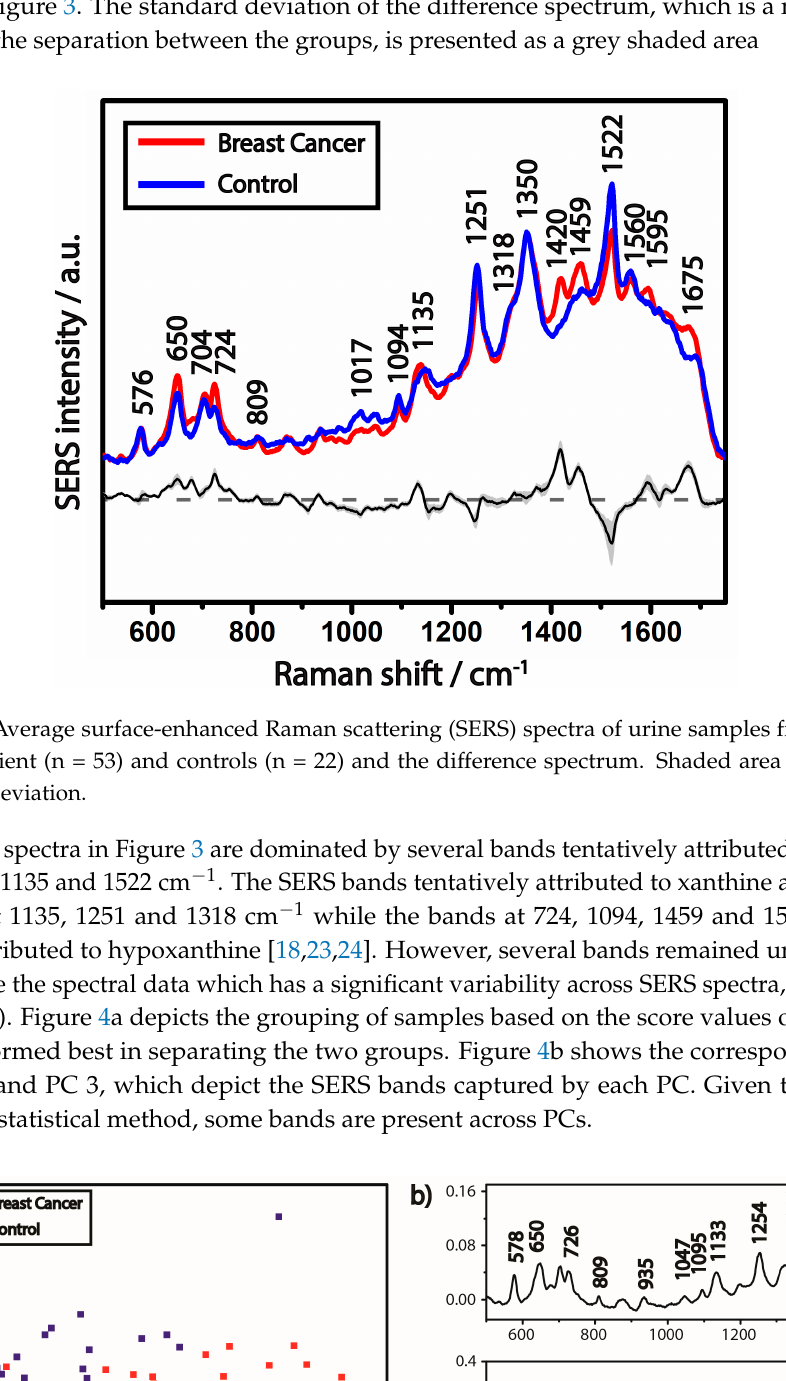
Figure 4. Principal component analysis of SERS acquired from patients with breast cancer (n = 53) and controls (n = 22). Score plot showing the separation of samples based on principal component